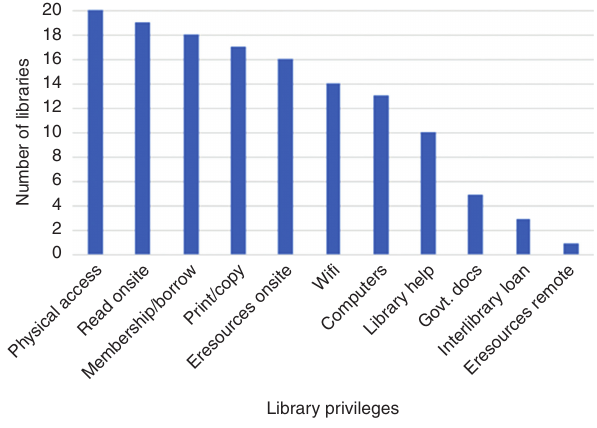
Fig. 2: Library privileges for external or unaffiliated